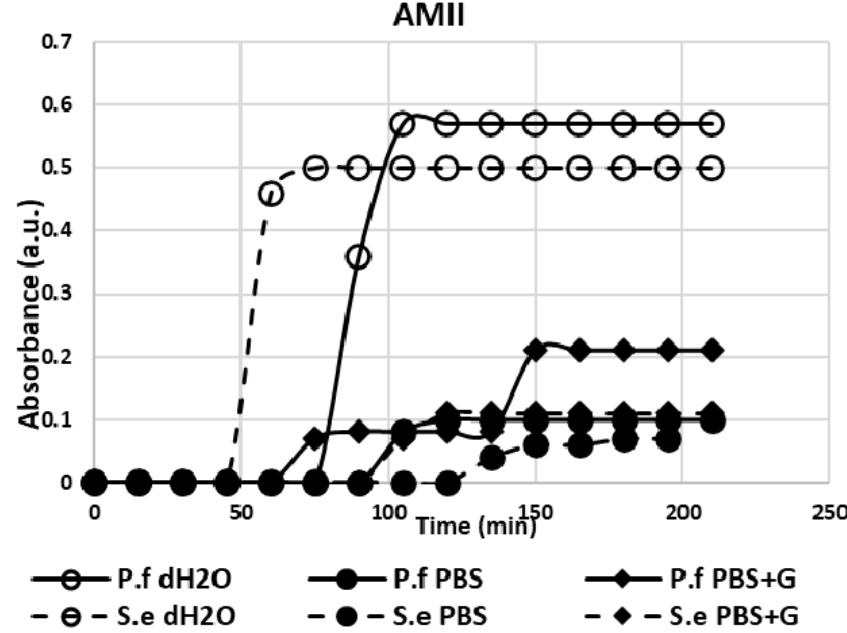
Figure 3. The evolution of Amide II (AMII) intensity band over the time.